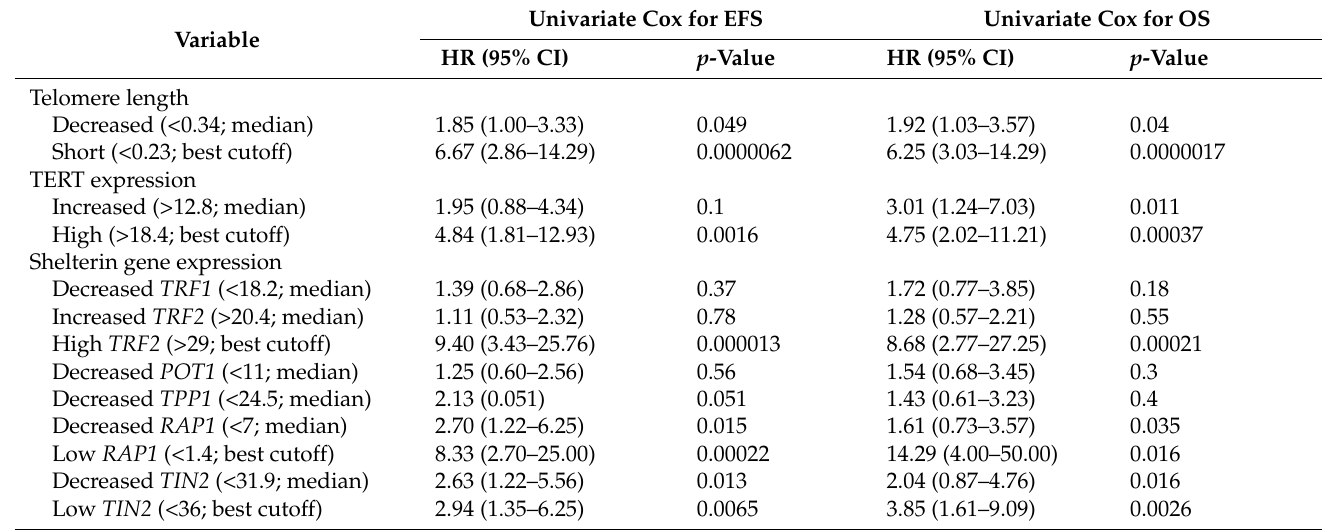
Table 2. Univariate analyses for event-free and overall survival in the advanced NSCLC cohort. Univariate Cox for EFS Univariate Cox for Variable